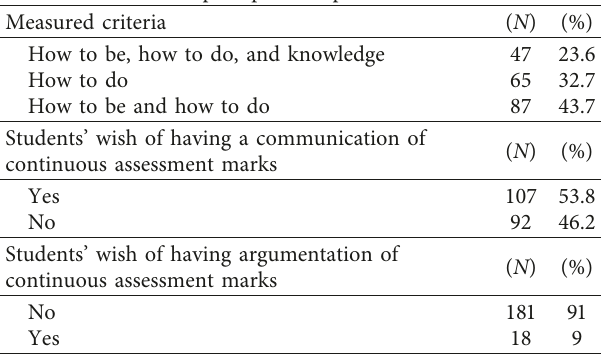
Table 2: Students’ perception of practical work assessment.